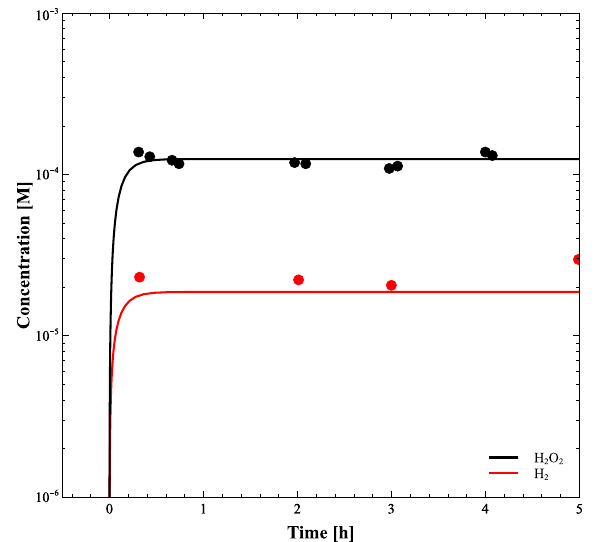
Figure 6. [H 2 ] and [H 2 O 2 ] during 6 h radiation at a dose rate of 2.5 Gy/s. The solid symbols represent the experimental data and the lines show the radiolysis model results.